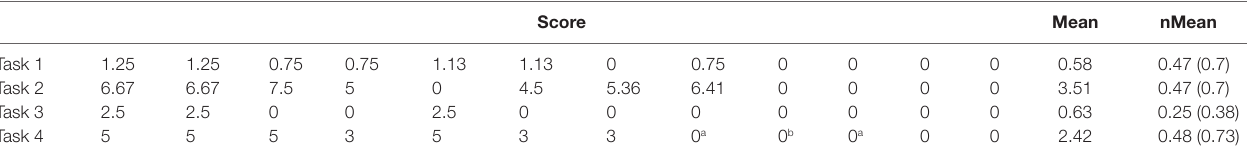
score Mean nMean